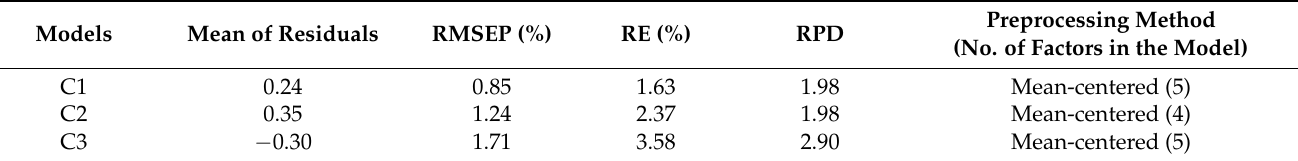
Figure 6. Comparison of reference and estimated values using PLSR models for each cluster: ( a ) Av Al 2 O 3 ; ( b ) Rx SiO 2 . Bars indicating residual standard deviation (RSD). Table 1. Results of the prediction of Av Al 2 O 3 with the models for each cluster.